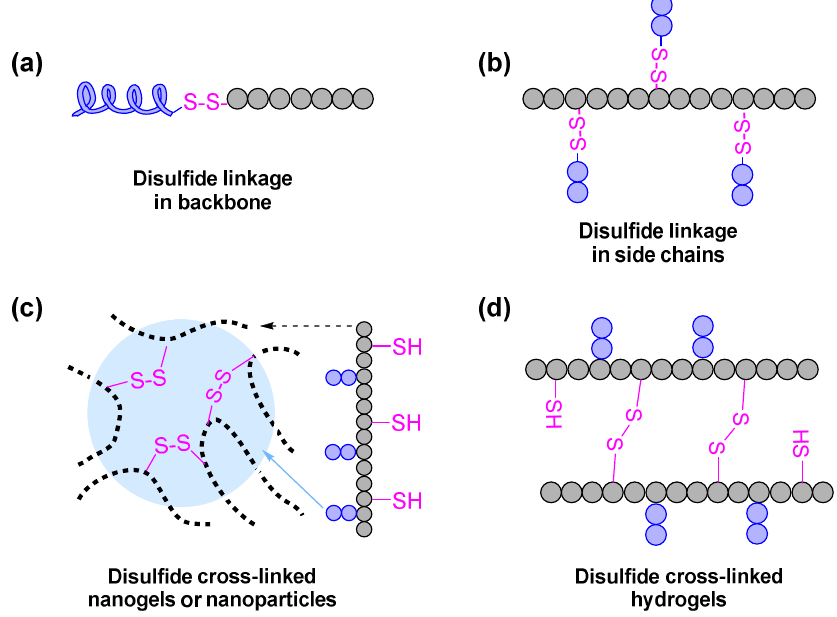
Figure 2. The redox-responsive PASPAm derivatives containing disulfide linkages ( a ) in backbone and ( b ) in side chains, and disulfide cross-linked ( c ) nanogels or nanoparticles and ( d ) hydrogels.